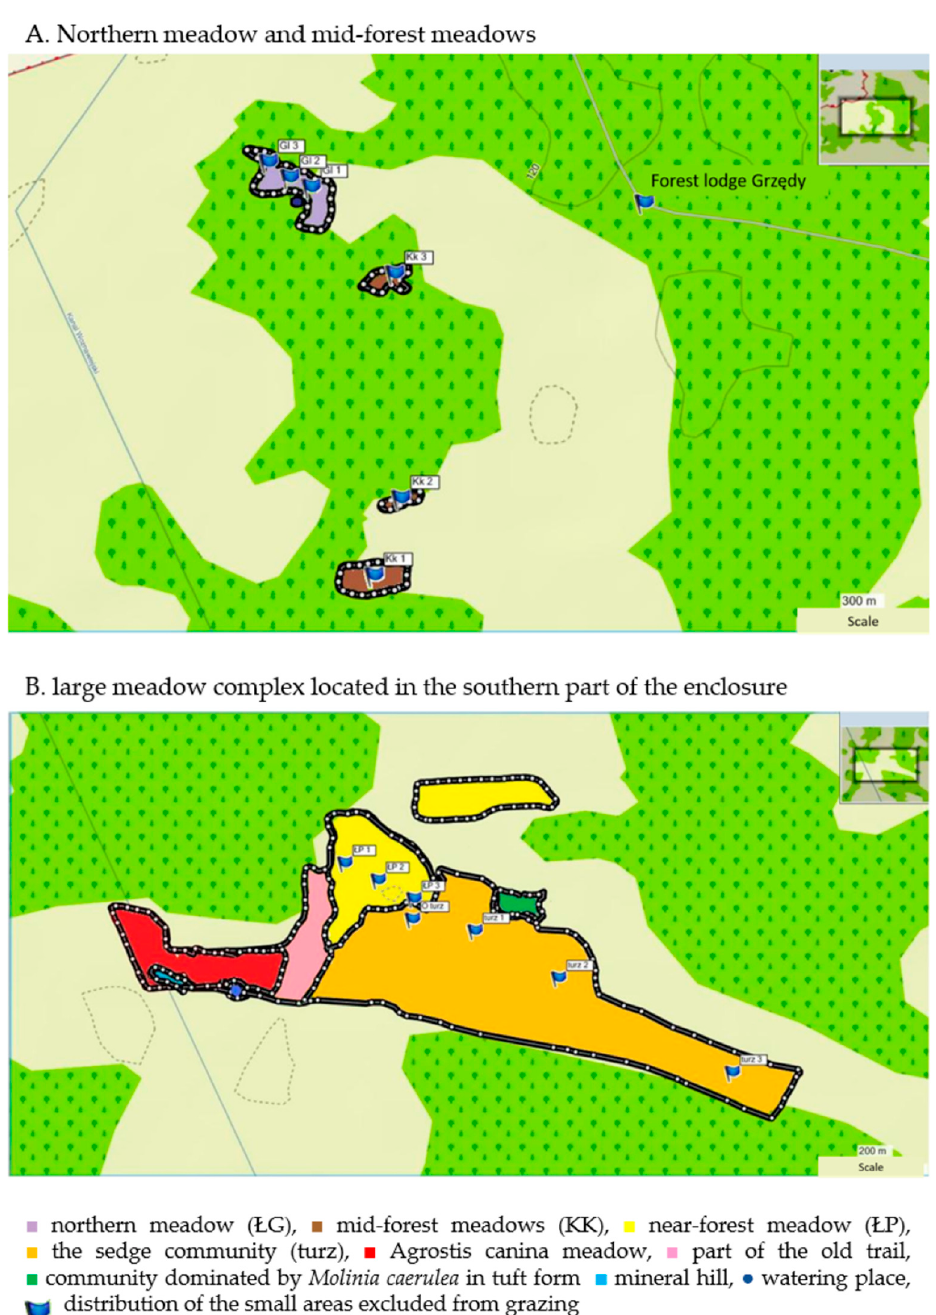
Figure A1. Location of the highlighted plant communities and location of fenced small areas excluded from grazing.